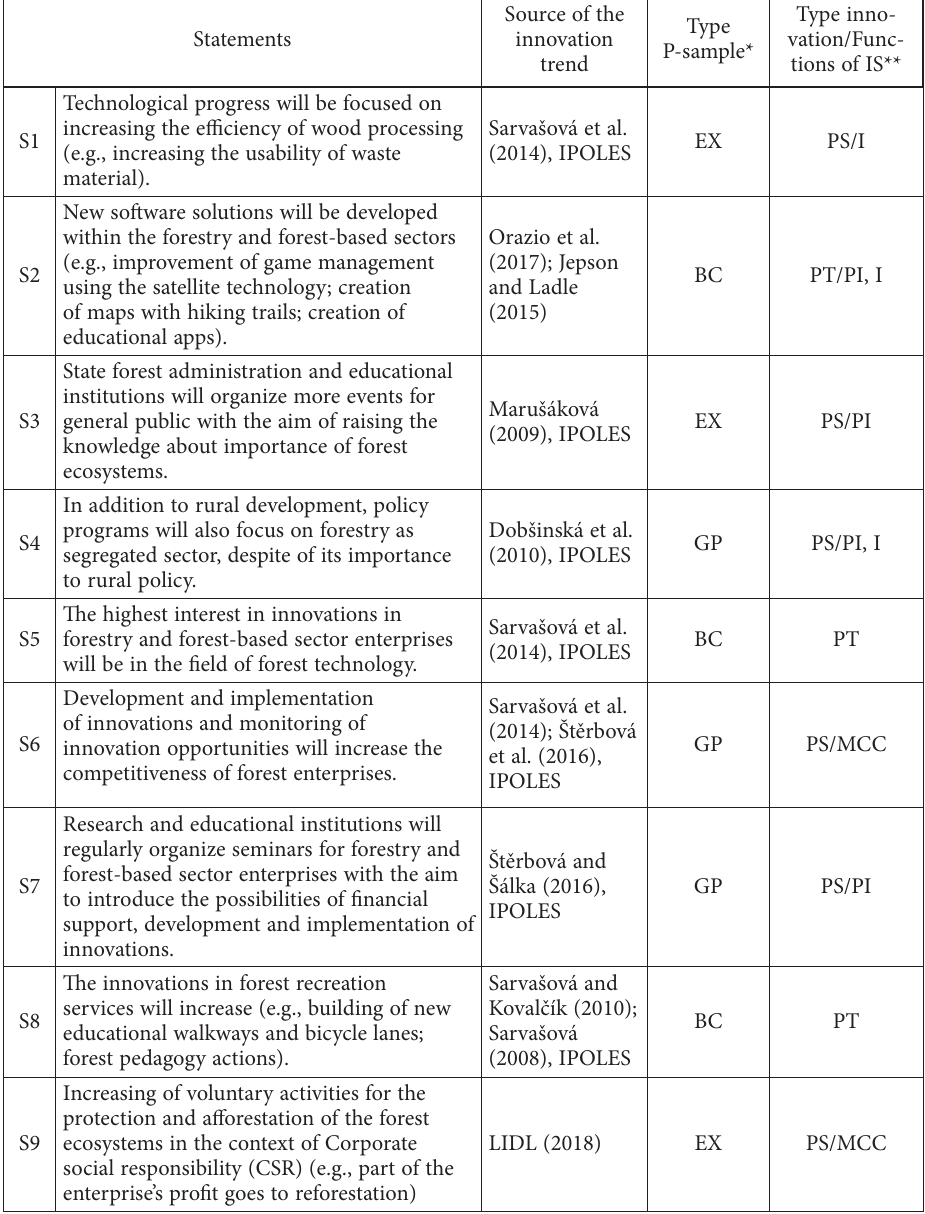
Table 1. Q – sample